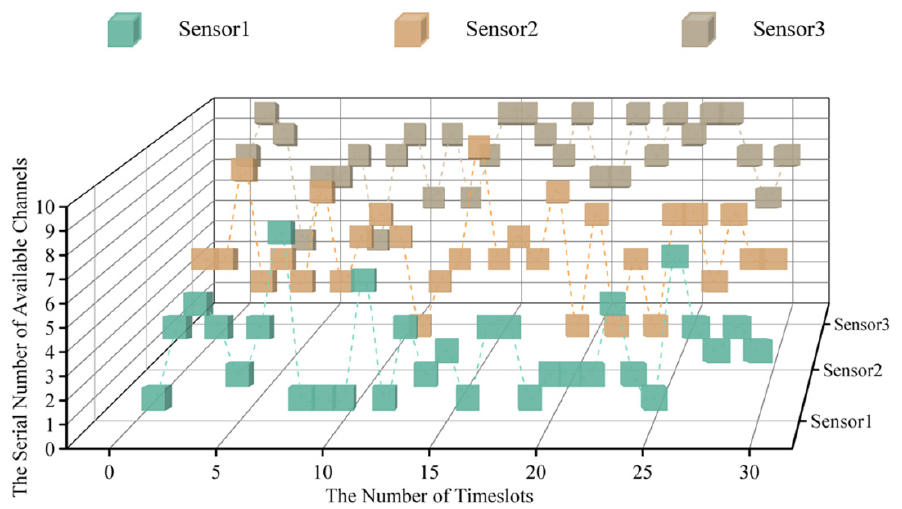
Figure 7. The cubic diagram of timeslot-channel selection in 3 sensor systems.